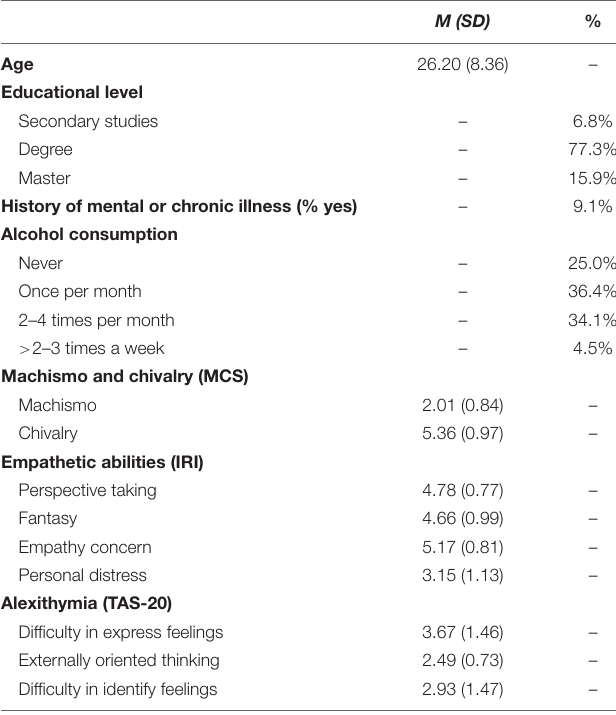
TABLE 1 | Descriptive statistics of sociodemographic and psychological trait measures ( N = 44).